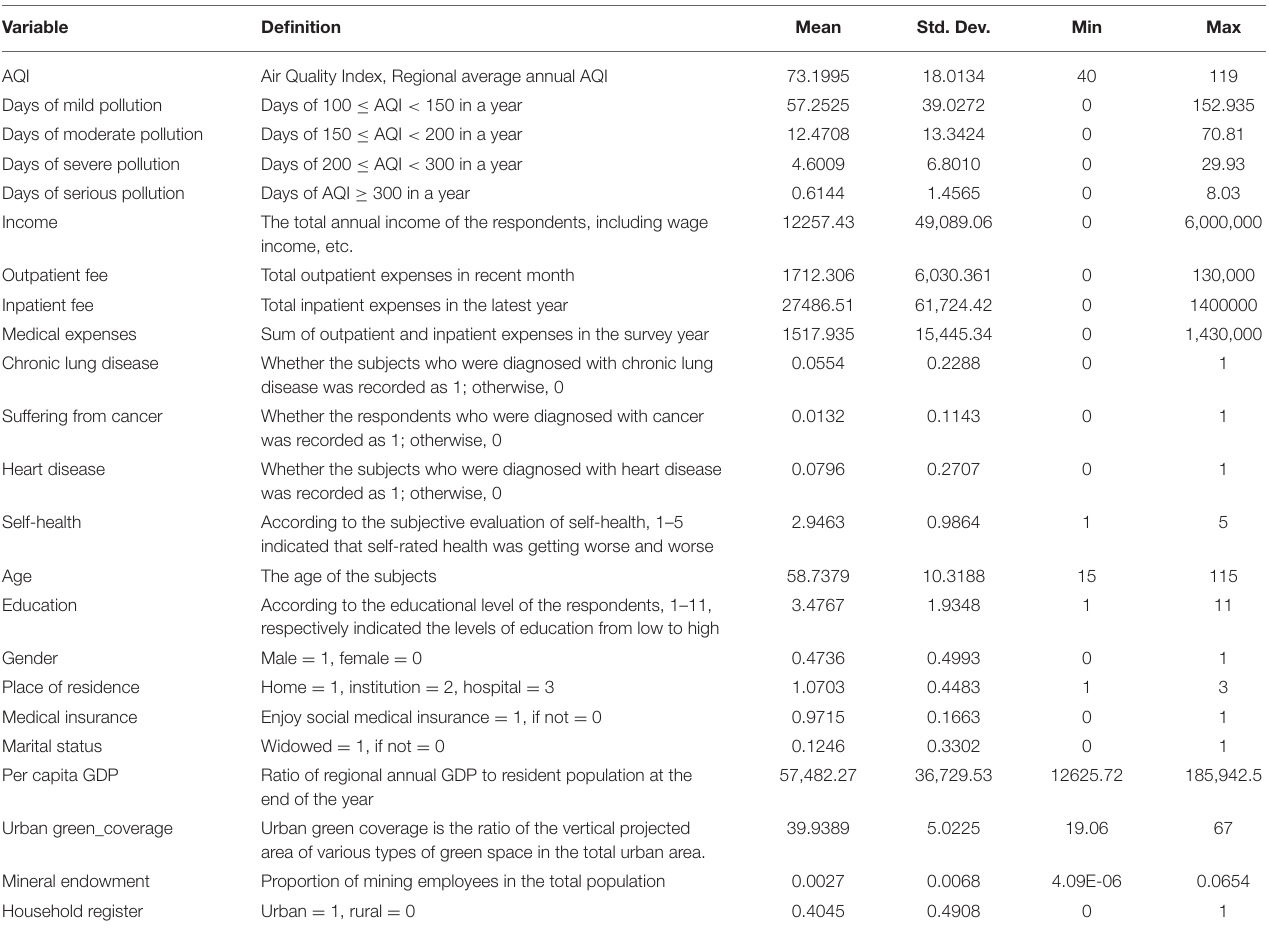
TABLE 1 | Variable definition and descriptive